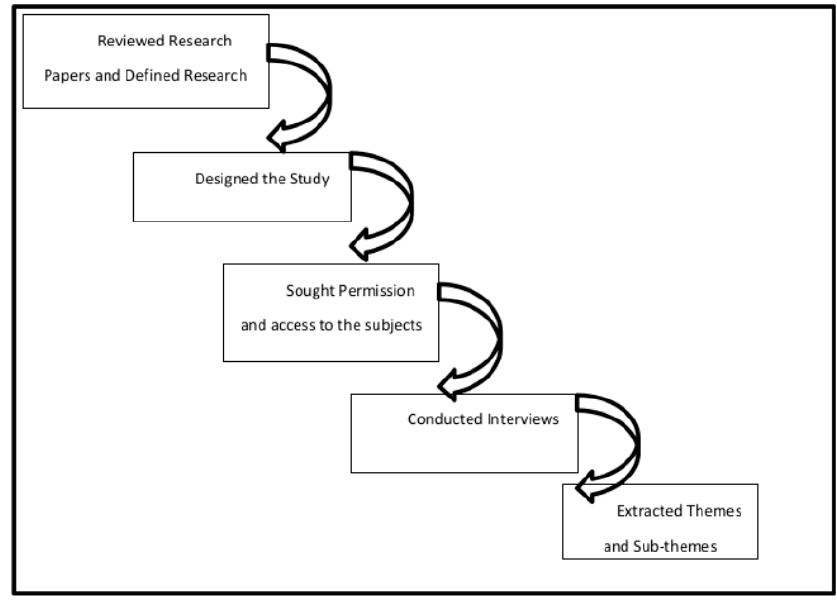
Figure 1. The response generation procedure.